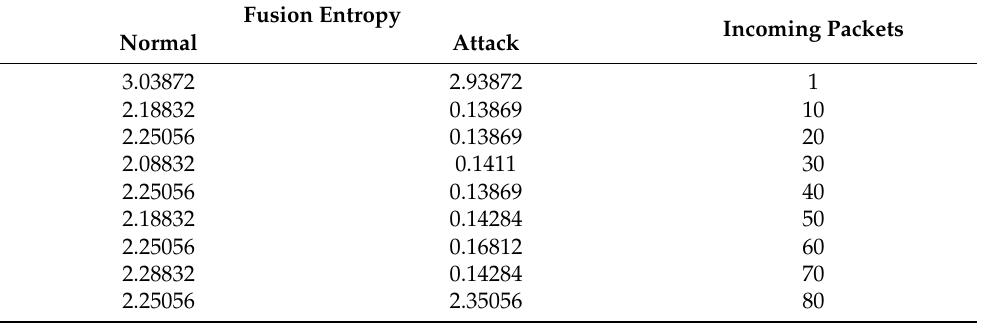
Table 4. Fusion entropy values.